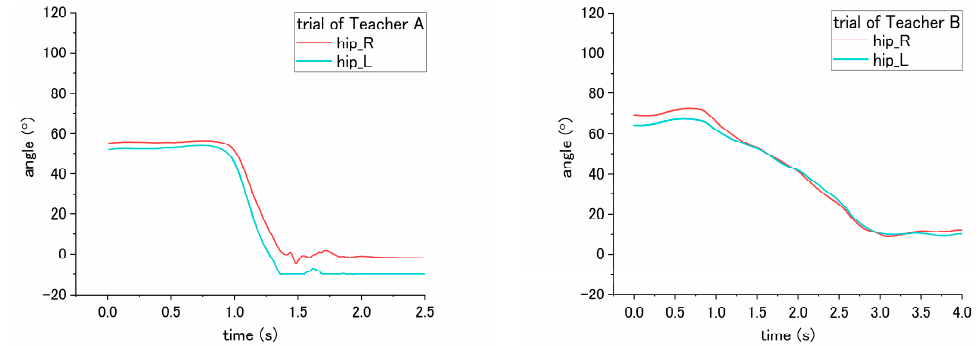
Figure 19. Flexion angle of patient’s hip joint during step No. 11 when incorrect way was conducted at step No. 11.